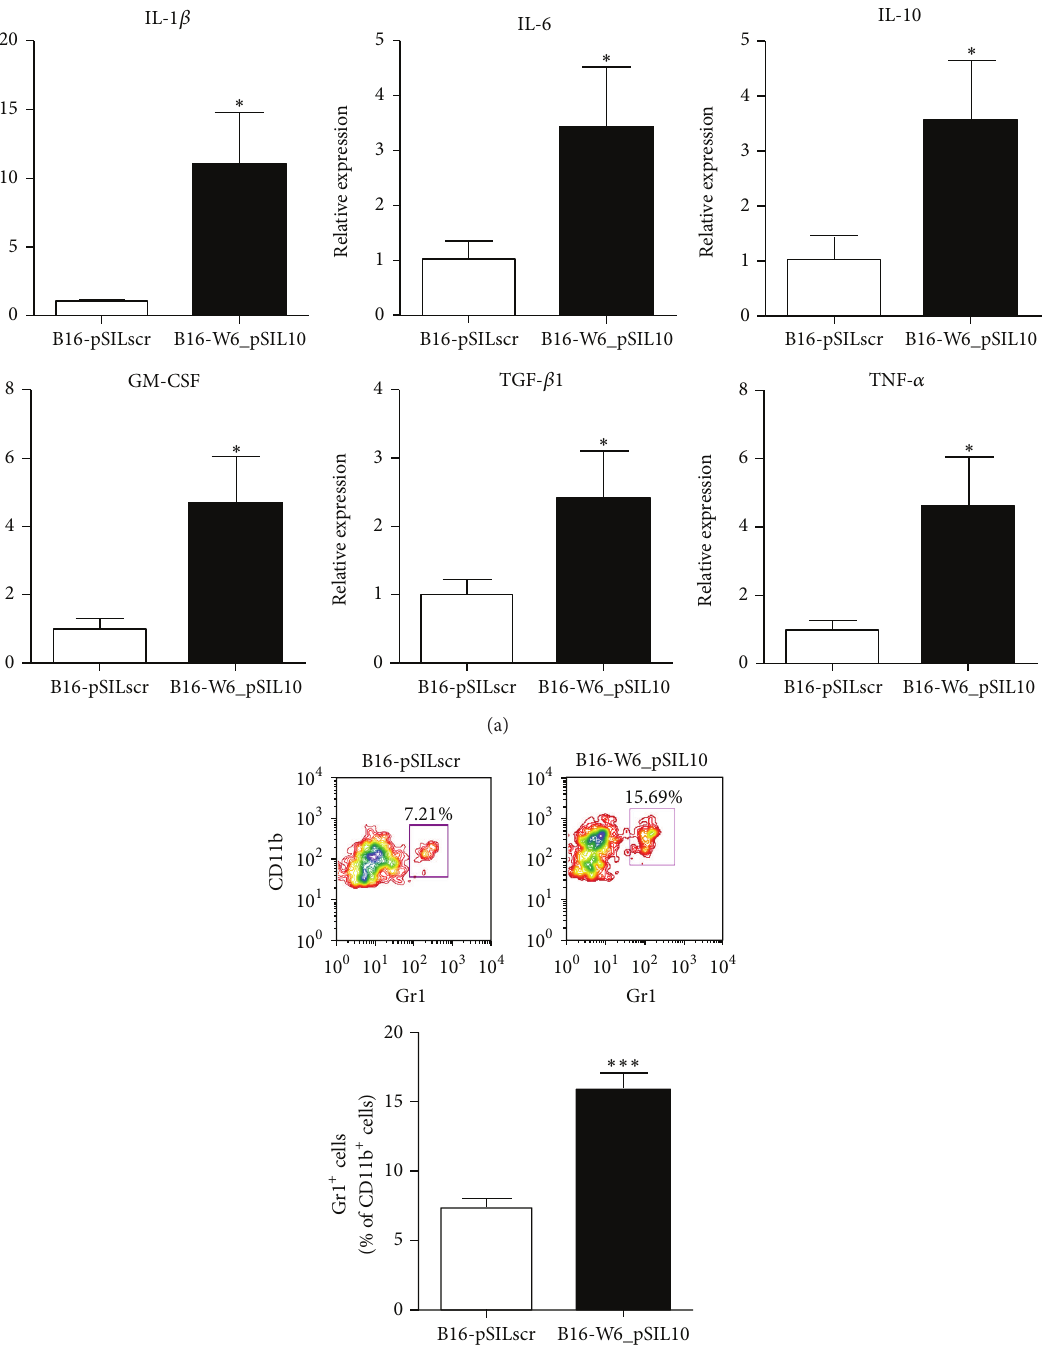
Figure 1: Downregulation of A-SMase increases the accumulation of MDSCs in melanoma. Tumours were resected when they reached the volume of ca. 500 mm 3 and treated to extract mRNA or obtain a cell suspension. (a) qPCR analysis of mRNA of IL-1 𝛽 , IL-6, IL-10, GM-CSF, TGF- 𝛽 1, and TNF- 𝛼 . The histograms are representative of results obtained from at least seven to twelve different animals per experimental group. (b) Flow cytometry analysis of tumour-infiltrating immune cells. The cell suspensions obtained from different tumours were stained with anti-CD11b-APC and anti-Gr1-FITC antibodies. A representative dot plot of CD11b + /Gr1 + cells in the CD11b + population cell is shown ( upper panel ). The histograms represent the results obtained from at least ten to fifteen different animals per experimental group ( lower panel ). Values are expressed as mean ± SEM. ∗∗∗ 𝑃 < 0.001 versus B16-pSILscr